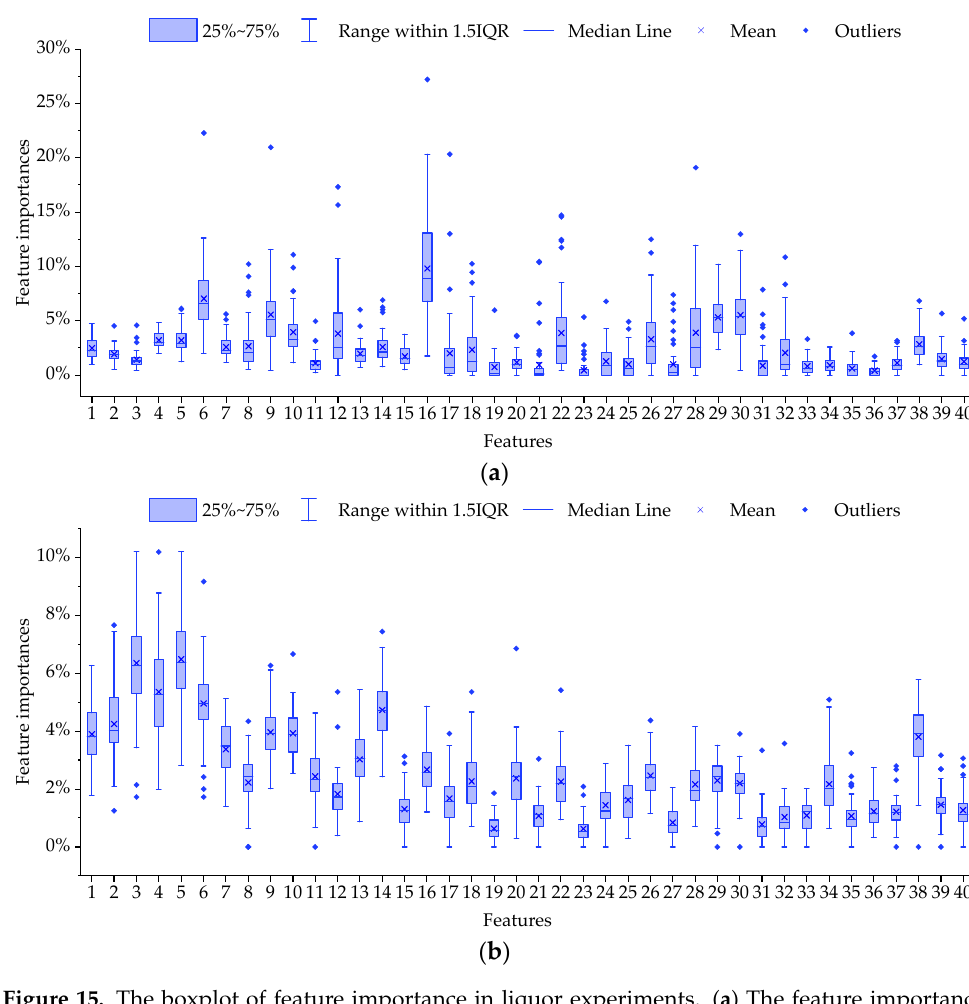
Figure 15. The boxplot of feature importance in liquor experiments. ( a ) The feature importance obtained by XGBoost; ( b ) The feature importance obtained by LightGBM.